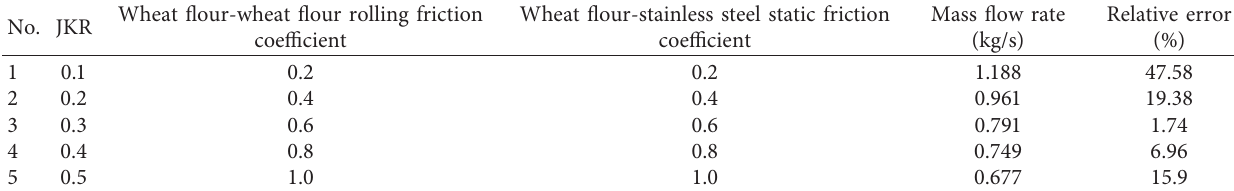
Table 5: Design and results of steepest ascent